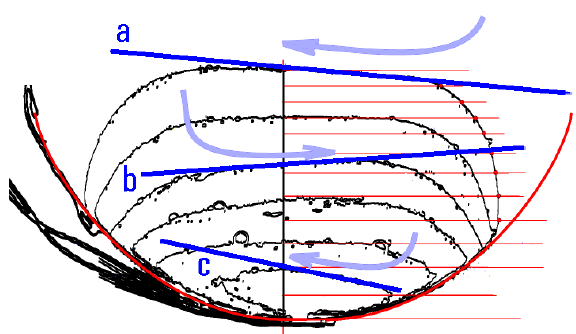
Fig. 23. Detailed views of the solid-body photographs show existence of very slow oscillatory motions. The top surface of the still solid (not yet molten) n -eicosane body are here fitted by straight lines. It is immediately apparent that the these lines (in blue colours) exhibit different slopes at differ- ent instants of time. Note in particular the slopes a, b, and c. of the small curvature radius of the solid body bottom, sitting inside a “bowl” at the bottom of the shell, with its larger radius. Such horizontal forces may be generated by sideways components of the flows, in Fig. 23 indicated by the blue arrows. Another obvious demonstrations of the inclined body variation are presented in Fig. 24, within the last moments of the solid body existence. The red contour slopes downwards to the right – while the blue contour